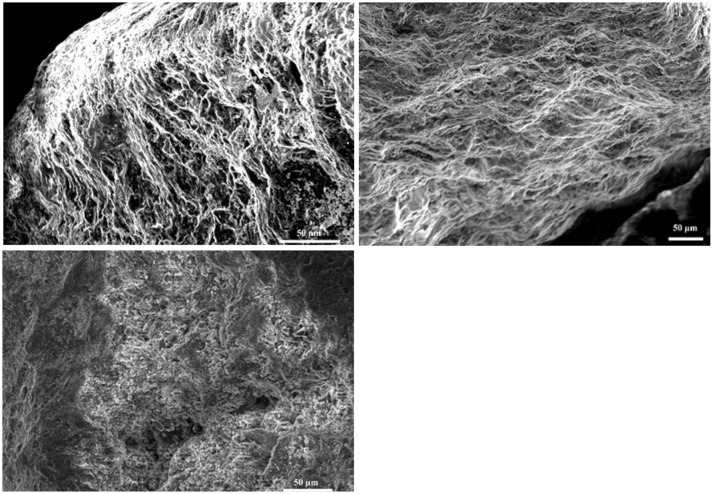
Images obtained by SEM microscopy. Upper left is a SEM image of basalt from the flight experiment and upper right a SEM image of basalt from the ground experiment. The control, lower right, is a SEM picture of the basalt after the 3 month experiment where no cells have been added and the surface of the basalt can be seen. Both in ground and flight experiment, biofilm covers the basalt surface. For the flight, less thick biofilm is seen as the surface is still visible and the biofilm does not cover the whole surface such as seen in the ground picture.